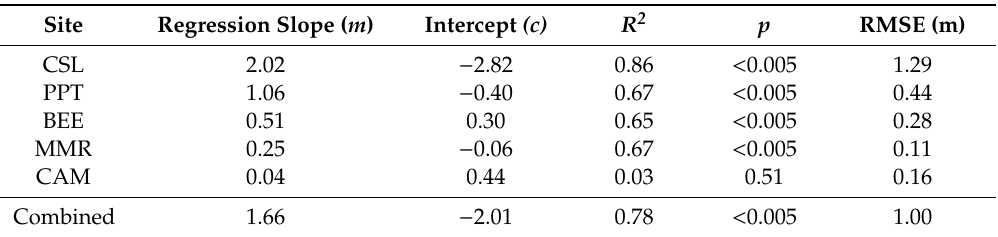
Figure 5. Significant swash height against o ff shore significant wave height (H 0 ). Left panel shows the incident gravity band (S g ). Right panel shows the infragravity band (S ig ), where the black line represents the linear best fit for all sites. Table 4. Relationship between significant swash in the infragravity band (S ig ) and o ff shore wave height (H 0 ). RMSE = root-mean-square